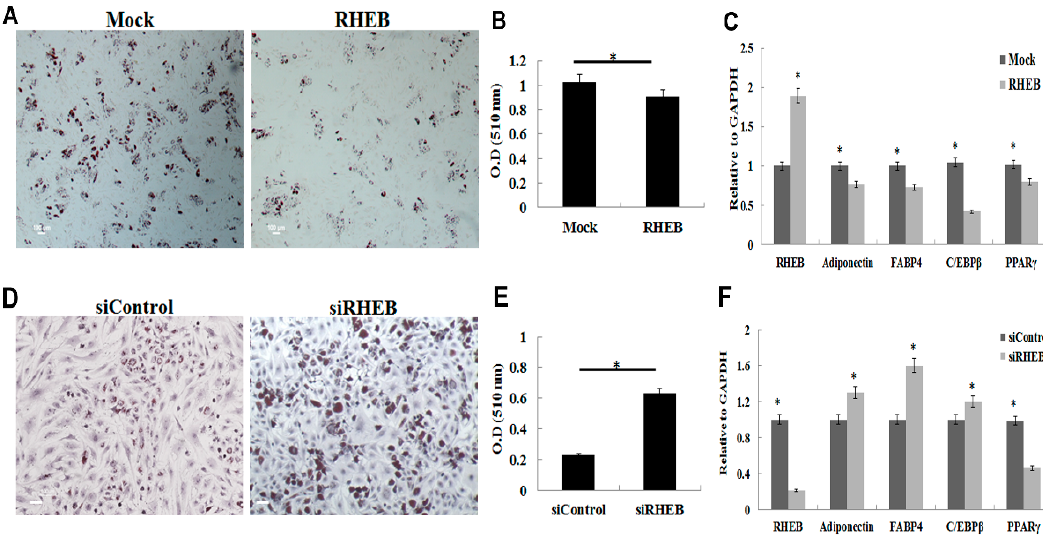
Figure 4. Effect of RHEB overexpression and knockdown on adipogenic differentiation of the ASCs. ( A ) Oil Red O staining as seen by higher levels of red colored fat droplets in mock-differentiated cells as compared to RHEB -differentiated cells; ( B ) quantification of extracted Oil Red O staining; ( C ) the mRNA expression analysis by quantitative real-time PCR after RHEB overexpression; ( D ) Oil Red O staining after RHEB knockdown; ( E ) quantification of extracted Oil Red O staining; ( F ) the mRNA expression analysis by quantitative real-time PCR after RHEB knockdwon. (Datas are shown for a representative experiment as averages of triplicates with standard deviation. The statistical significance of differences was calculated using the Student’s t -test. * p < 0.05; Scale bar: 100 μ m).